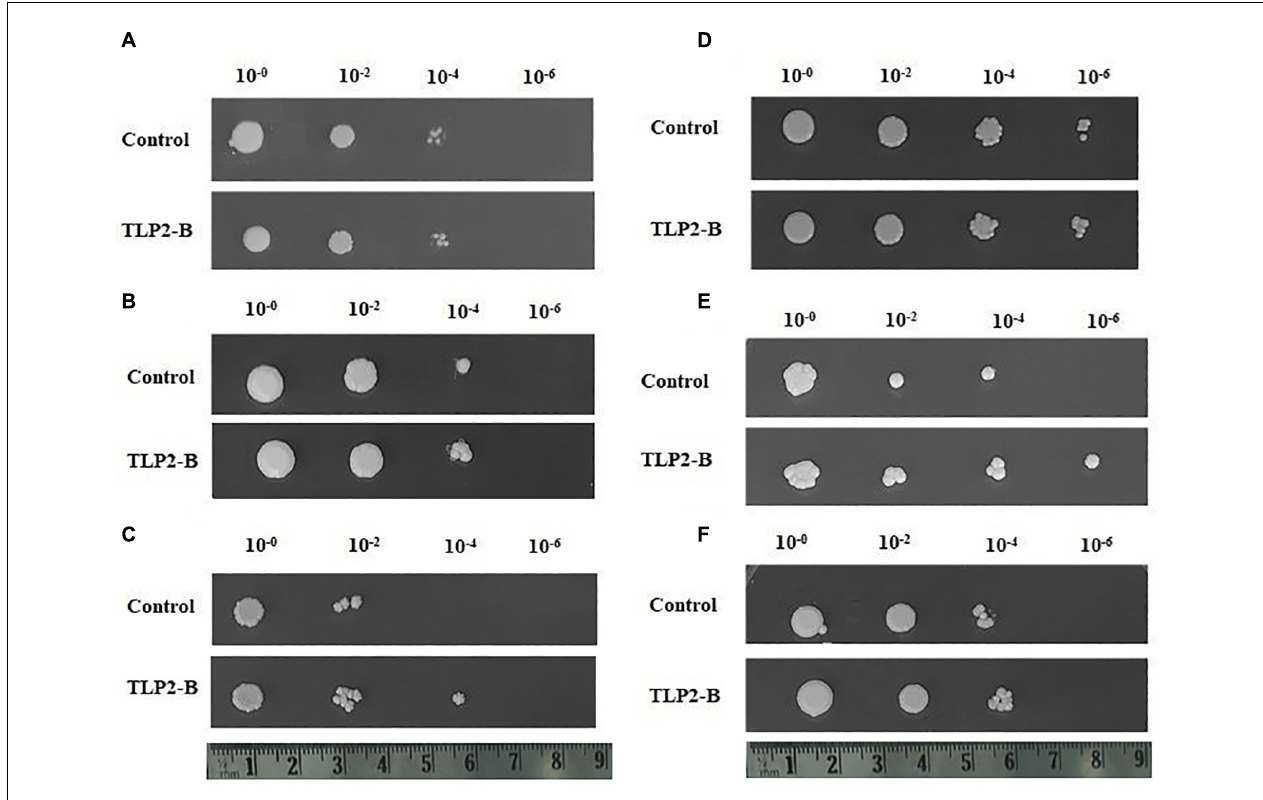
FIGURE 9 | Spot assay of recombinant Saccharomyces cerevisiae (yeast) cells under various stress conditions. (A) Shows similar growth of both TaTLP2-B (pYES2.1-TaTLP2-B) and control vector (pYES2.1/V5-His/lacZ) containing yeast cells under control conditions. (B–F) Shows the spot assay analysis of TaTLP2-B and control vector containing yeast cells in (B) cold (4 ◦ C), (C) osmotic (30% PEG), (D) heat (37 ◦ C), (E) combined heat and osmotic (37 ◦ C and 30% PEG), and (F) salt (1M NaCl) stress conditions,